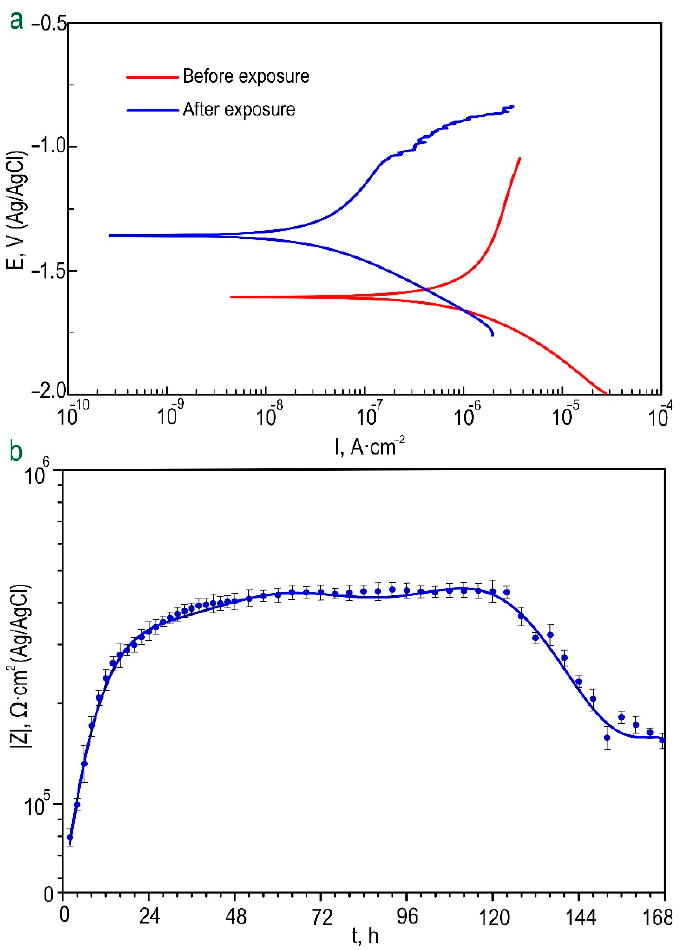
Figure 8. Polarization curves obtained for samples with HC-0.1-2 before and after 7 days of exposure to Hanks’ solution ( a ); dynamics of change in the impedance modulus, measured at a low frequency (| Z | f =0.1Hz ) during the exposure time of samples with HC-0.1-2 to Hanks’ solution ( b ).